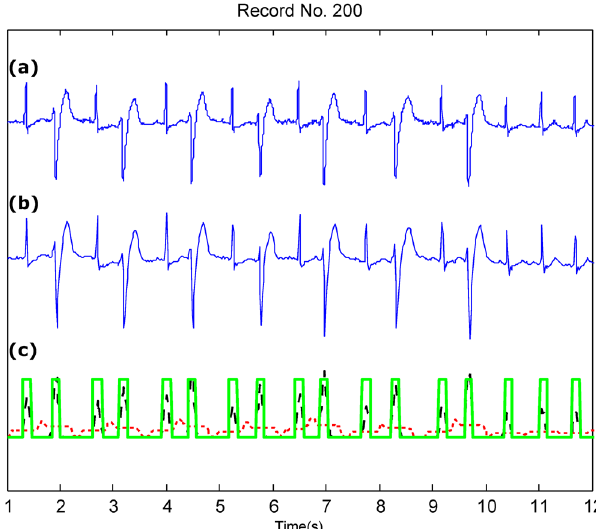
Figure 3. QRS detection over Record 200 of the MIT-BIH Arrhythmia Database with irregular beats (premature ventricular contractions). ( a ) Original ECG signal ( b ) Compressed ECG signal using Method III ( c ) Compressed ECG signal using Method III with adaptive thresholding and detected QRS complexes (green blocks). Signal amplitudes have been manipulated to fit all signals in one figure. Here, the red dotted line represent the first moving average where the black dashed line represents the second moving